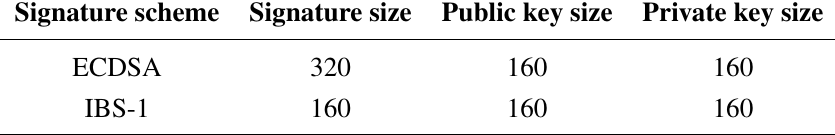
Table 1. IBS-1 and ECDSA signature size comparison, considering an MNT (Miyaji, Nakabayashi and Takano) elliptic curve over a prime field with 80 bits security level.